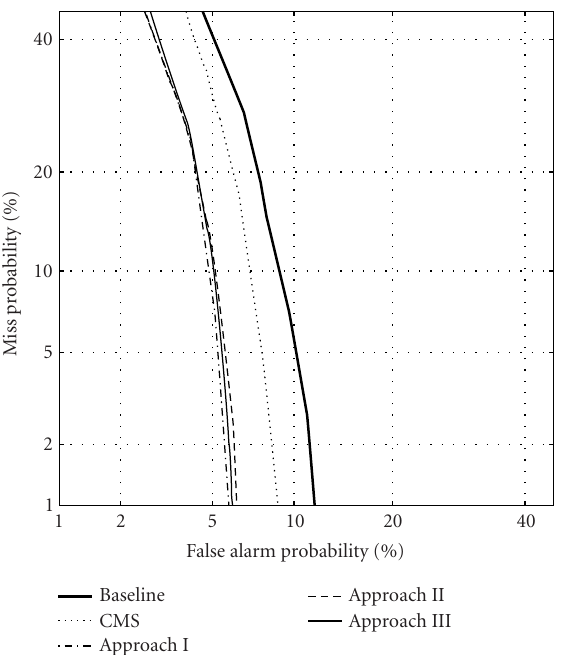
Figure 3: DET curves obtained by using the seen handset cb1 in the verification sessions. Handsets cb3 and cb4 were used as the unseen handsets.